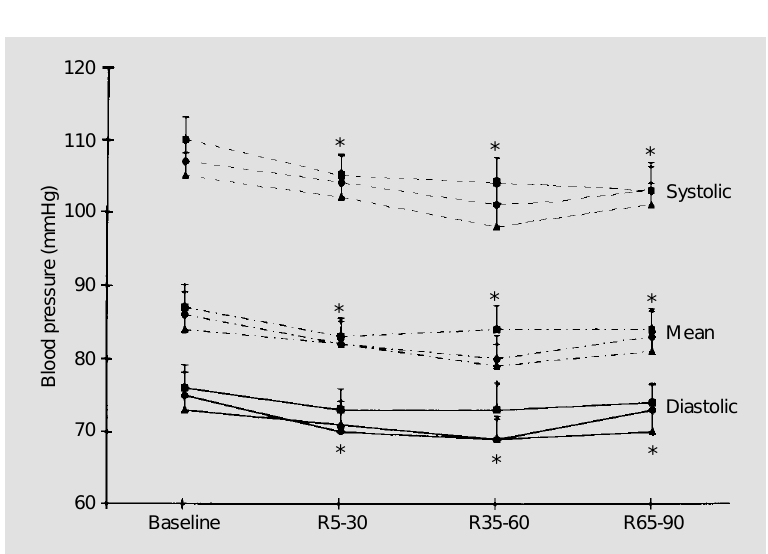
Figure 1 - Systolic, mean, and diastolic blood pressures at baseline and after exercise (R5- 30, mean value between 5 and 30 min; R35-60, mean value between 35 and 60 min; R65- 90, mean value between 65 and 90 min) performed at 30 (filled squares), 50 (filled circles) and 80% (filled triangles) of VO 2 peak. *P<0.05 compared to baseline ( two-way analysis of variance for repeated measures and Scheffé ’ s post-hoc test).